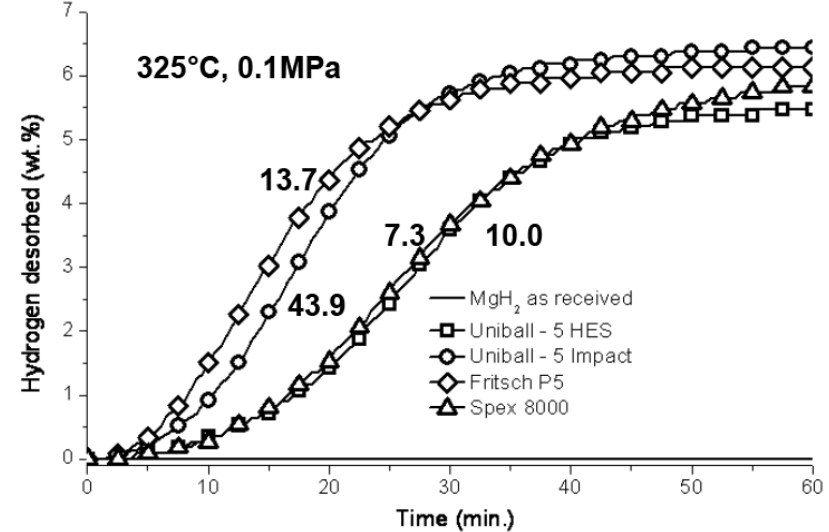
Figure 3 . Desorption curves of nanocrystalline MgH different types of ball mills. Specific surface area (SSA) of each powder is shown in m 2 /g beside each desorption curve. Adapted from [18].